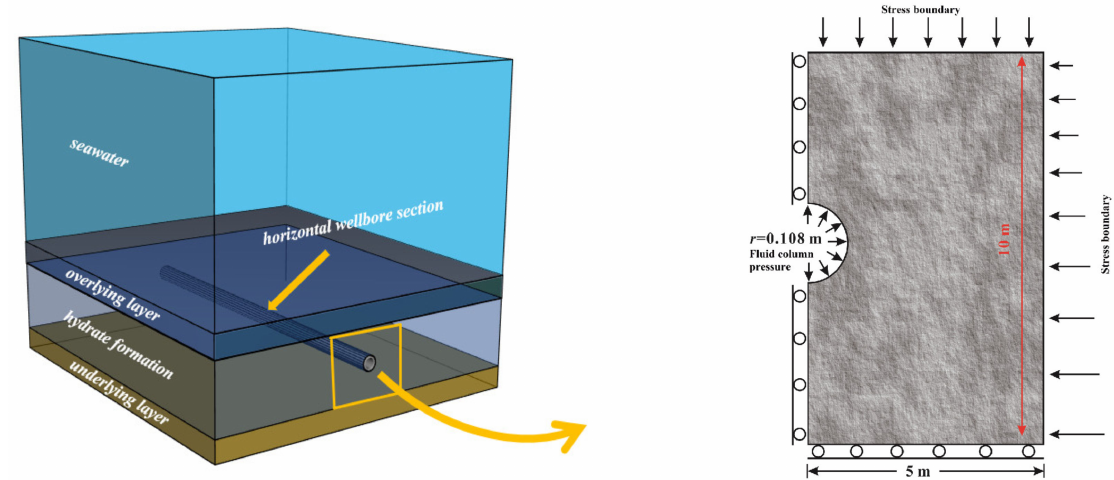
Figure 1. Diagram of the drilling fluid invasion and wellbore stability model during horizontal drilling. Table 1. Main reservoir parameters and drilling fluid property parameters for